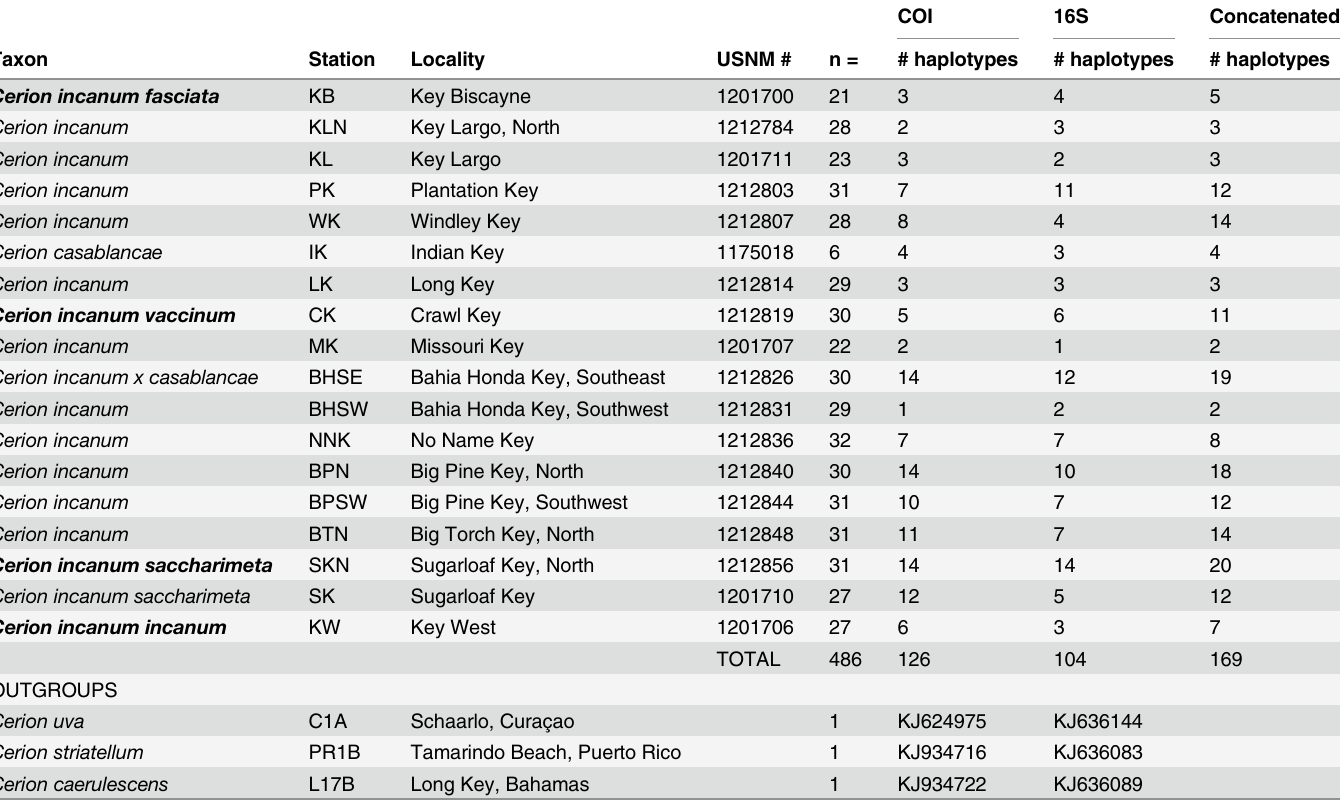
Table 1. Florida Keys populations of Cerion sampled for this study. The numbers of individuals sequenced from each population for the mitochondrial cytochrome c oxidase 1 and 16S rDNA genes, the numbers of different haplotypes within each population for each of the partial gene sequences, as well as for the concatenated sequences are provided. Samples from the type localities of named taxa are in bold. GenBank accession numbers for the various haplo- types of Cerion incanum , C . cassablancae and their hybrids are provided in Appendix